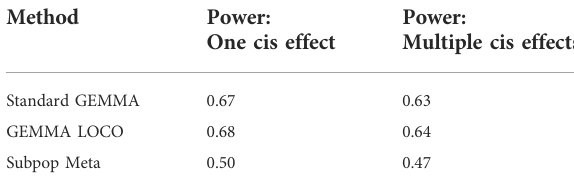
TABLE 2 Power for standard GEMMA, GEMMA LOCO, and subpopulation meta-analysis applied to the two simulation settings with cis effects in the 43 strain simulations. Power is the proportion of genes with at least one nonzero cis-SNP effect that